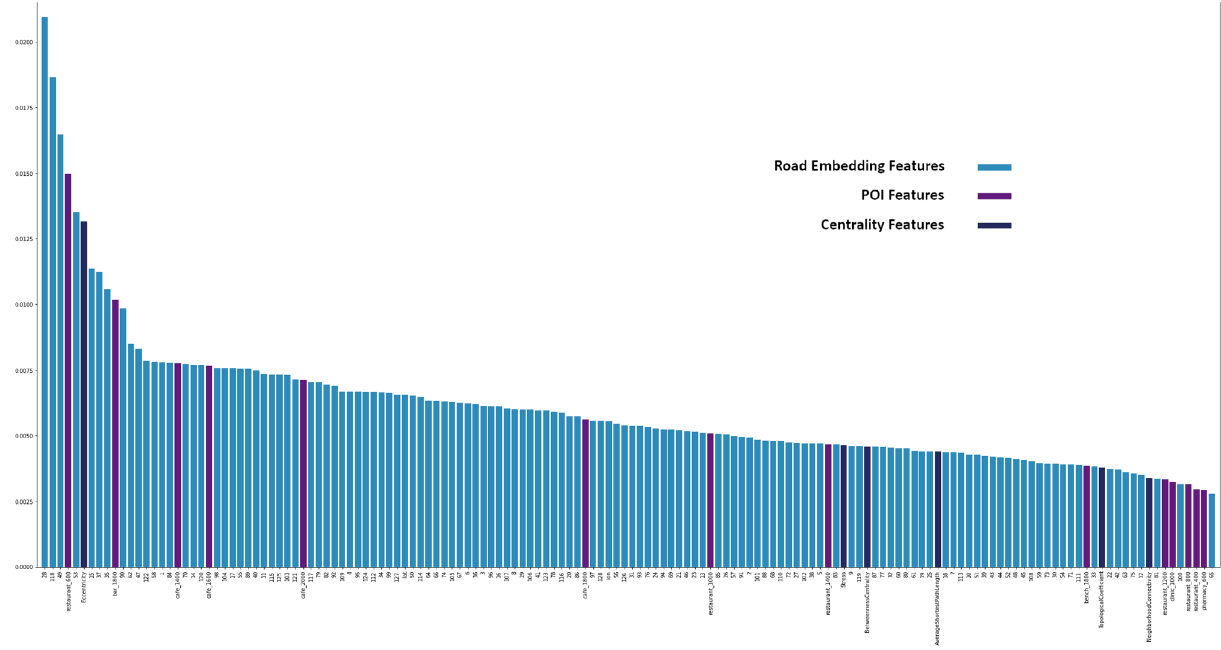
Figure 5. Top 150 features. While a noticeable difference is observed among the top 13 features, we can observe a steady trend among most embedding features. Embedding feature importance account for most of the feature importance. We can also observe that despite having the highest number of features (530) only a small number of POI features appear in the top 150 features. (Bar plot generated through matplotlib 45 Version 3.4.3 from matplotlib.org).